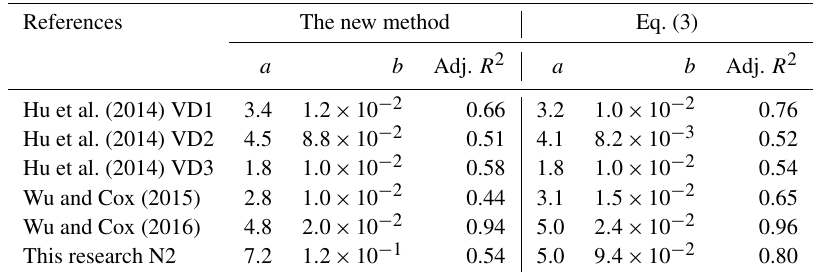
Table 4. Outcome of the factors in Eq. (15) between KC and C D by the new method and by Eq.